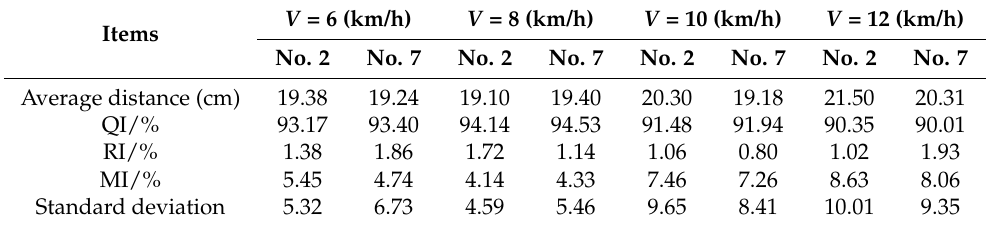
Table 5. Results of the seeding performance at different operating speeds.